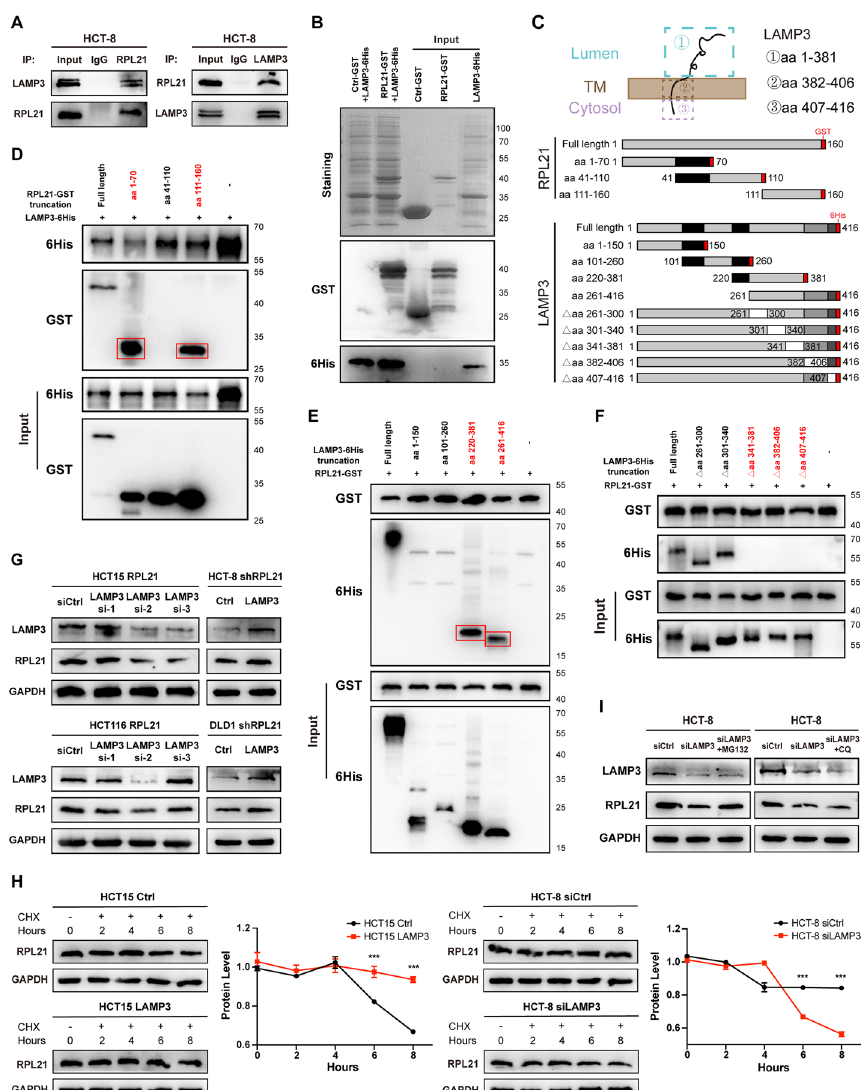
Fig. 5 LAMP3 directly interacted with RPL21 and enhanced the stability of the RPL21 protein. A RPL21 and LAMP3 were immunoprecipitated in HCT-8 cells detected by western blotting. B Direct binding of RPL21-GST and LAMP3-6His using the His pull-down assay. The pull-down bands were detected by Coomassie brilliant blue staining and western blotting. C Topology of LAMP3, including the luminal segment (aa 1–381), the transmembrane segment (aa 382–406), and the cytoplasmic segment (aa 407–416). Diagrammatic representation of RPL21 and LAMP3 with their truncated/deleted mutation forms. D – F HEK293T cells were transfected with the indicated constructs and immunoprecipitated with anti-6His ( D ) or anti-GST ( E , F ). The red boxes represent the pull-down bands detected by western blotting. G LAMP3 and RPL21 protein expression in the indicated cells was detected by western blotting. H The degradation of the RPL21 protein in HCT15 Ctrl, HCT15 LAMP3, HCT-8 siCtrl, and HCT-8 siLAMP3 cells with CHX treatment (50 μg/mL) was detected by western blotting. The quantification of the protein level was normalized to that of GAPDH. Mean SD, n 3, *** p < 0.001, Student’s t -test. I LAMP3 and RPL21 protein expression in HCT-8 siCtrl, HCT-8 ± = siLAMP3, and HCT-8 siLAMP3 cells treated with MG132 (10 μM, 4 h) or CQ (50 μM, 2 h) was detected by western